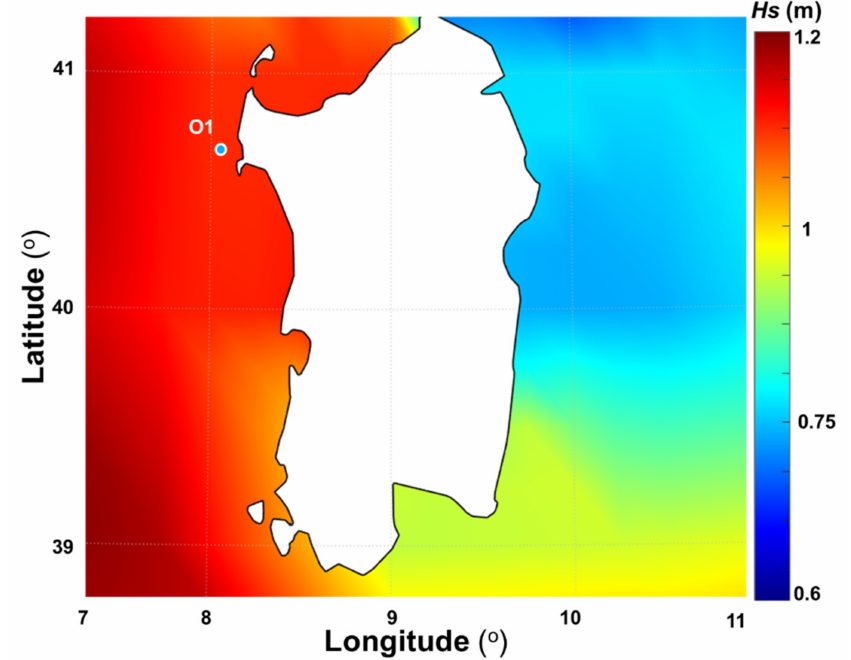
Figure 3. Hs spatial distribution (average values) considering the 40-year time interval (January 1979 to December 2018) of ERA-interim data. The map also indicates the position of the point O1 that is considered to assess the wave conditions in the vicinity of the simulating waves nearshore (SWAN) computational